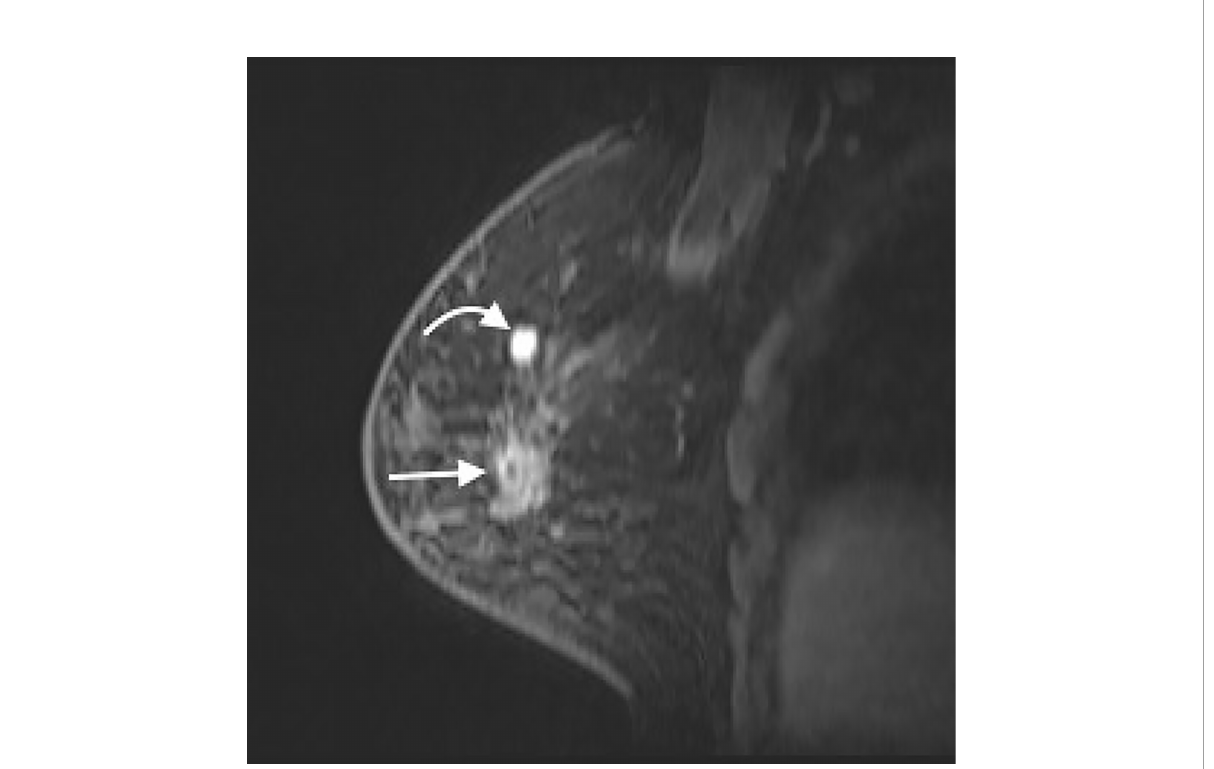
FIGURE 1 CE-MRI (sagittal view) of right breast showed a 3.1-cm irregular enhanced mass (straight arrow) and a 1.1-cm circumscribe enhanced mass (curved arrow) in the upper region of right breast. CE-MRI, contrast-enhanced magnetic resonance